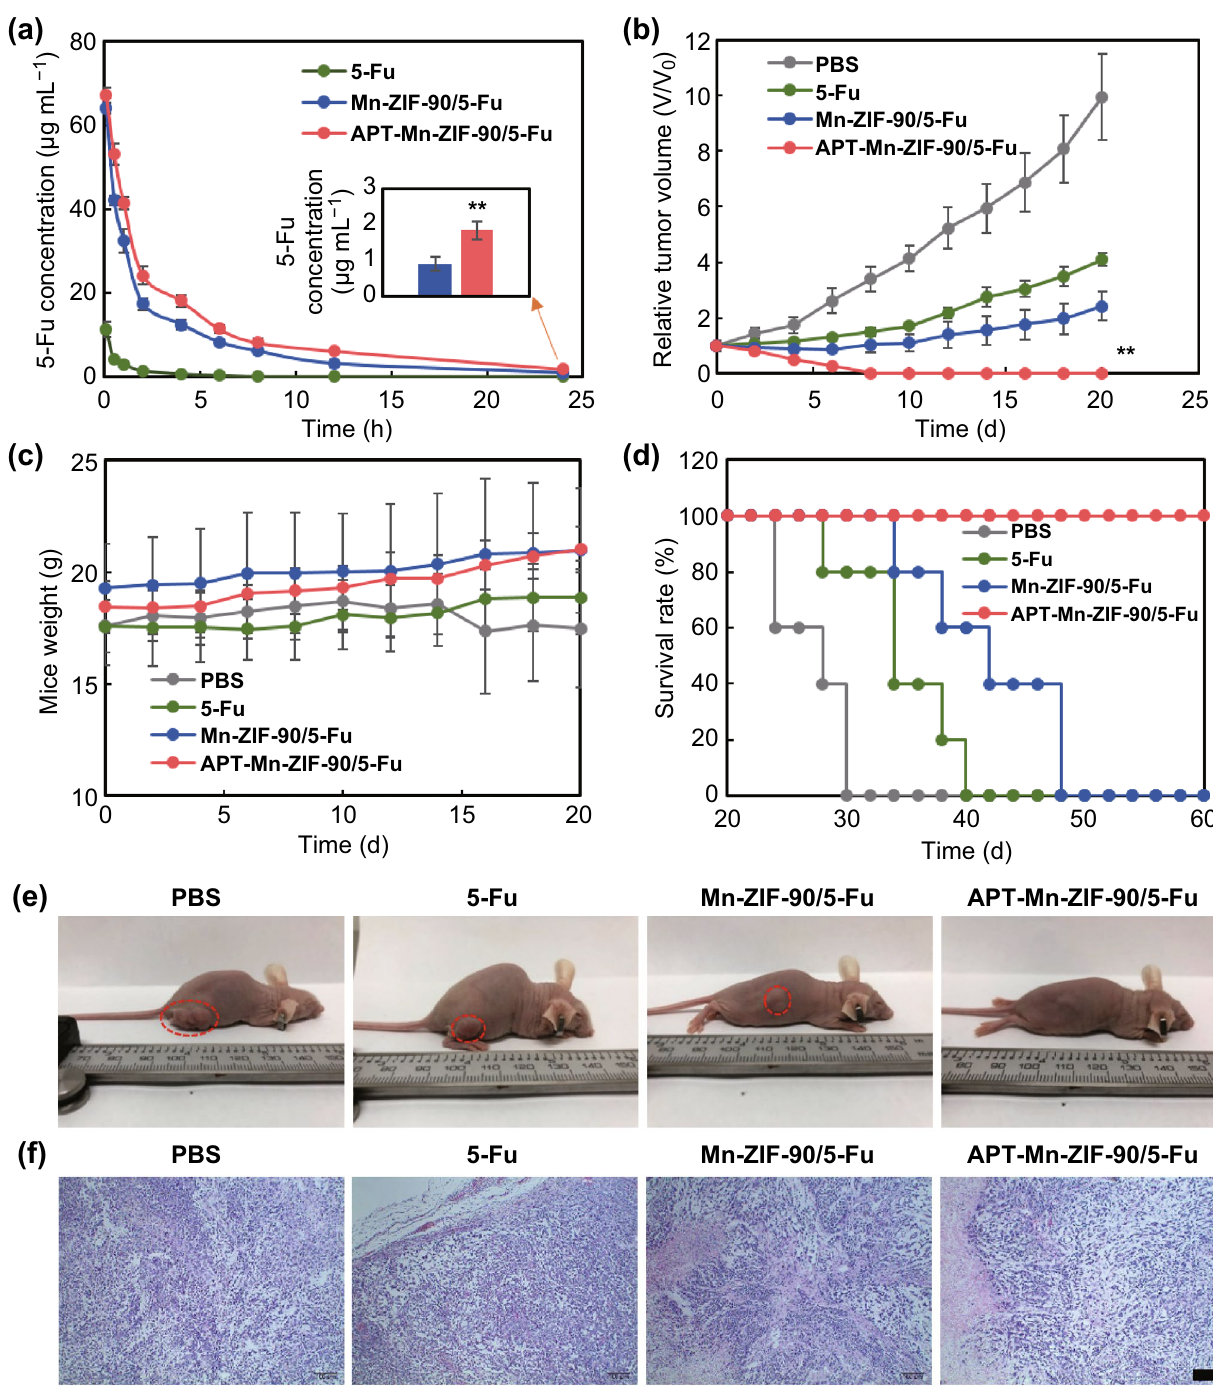
Fig. 7 a Blood concentration of 5-Fu at different time points after intravenous injection of 5-Fu, Mn-ZIF-90/5-Fu, and APT-Mn-ZIF-90/5-Fu, with 5-Fu concentration of 8 mg kg −1 . The pharmacokinetics of 5-Fu follows the three-compartment model. Mean ± SD ( n = 3); b relative tumor volume, c body weight, and d survival rate of tumor-bearing mice after treatment with PBS, 5-Fu, Mn-ZIF-90/5-Fu, and APT-Mn-ZIF-90/5-Fu, with 5-Fu concentration of 8 mg kg −1 . Mean ± SD ( n = 5), ** p < 0.01; e photograph of tumor-bearing mice 14 days post-injection; f H&E stain- ing of tumors for one treatment after 24 h (scale bar = 100